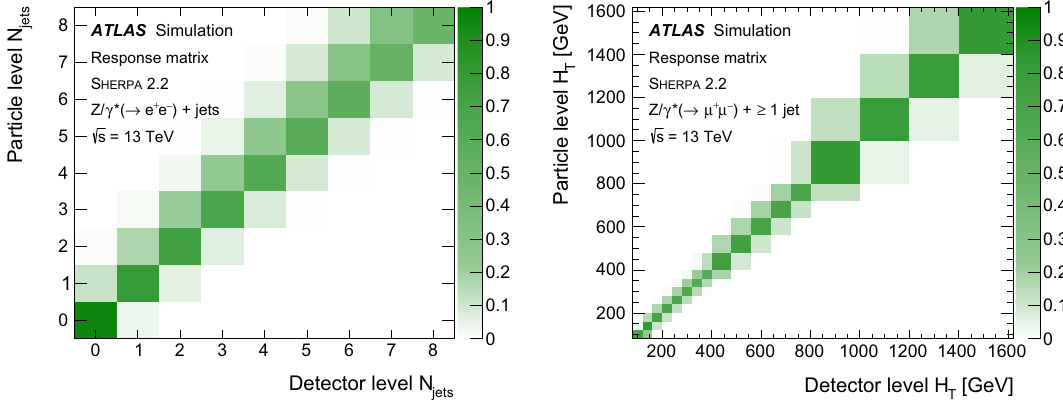
Fig. 2 Response matrices corresponding to the exclusive jet multiplicity for Z + jets events in the electron channel ( left ) and to the H T for Z + ≥ 1 jet events in the muon channel ( right ). The sum of the entries in each row is normalised to unity. Both matrices are obtained from Sherpa 2.2